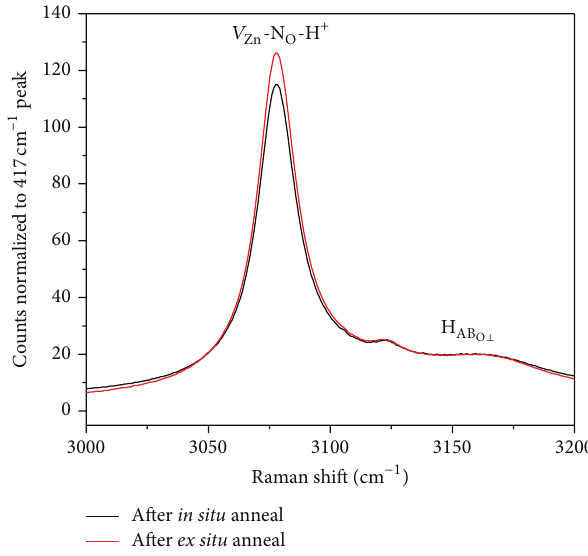
Figure 4: Raman spectra of a N-doped ZnO film exhibits the 𝑉 -N O -H + single acceptor complex at a vibration frequency of Zn 3078 cm −1 after the in situ anneal (black) as well as after an ex situ 800 ∘ C O 2